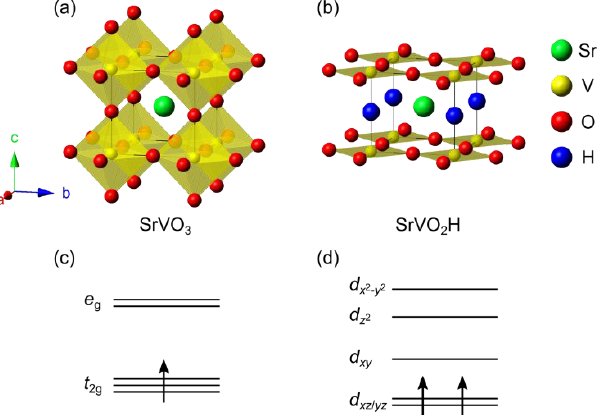
Figure 1. Crystal structures of ( a ) SrVO 3 (space group Pm –3 m ) and ( b ) SrVO 2 H (space group P 4/ mmm ). Green, yellow, red and blue balls represent Sr, V, O and H atoms, respectively. The solid lines indicate unit cells. The crystal field splitting for ( c ) SrVO 3 and ( d ) SrVO 2 H. Further splitting of SrVO 2 H’s half-filled ( d xz / yz ) 2 band occurs due to on-site Columbic repulsion , leading to a Mott insulating ground state.